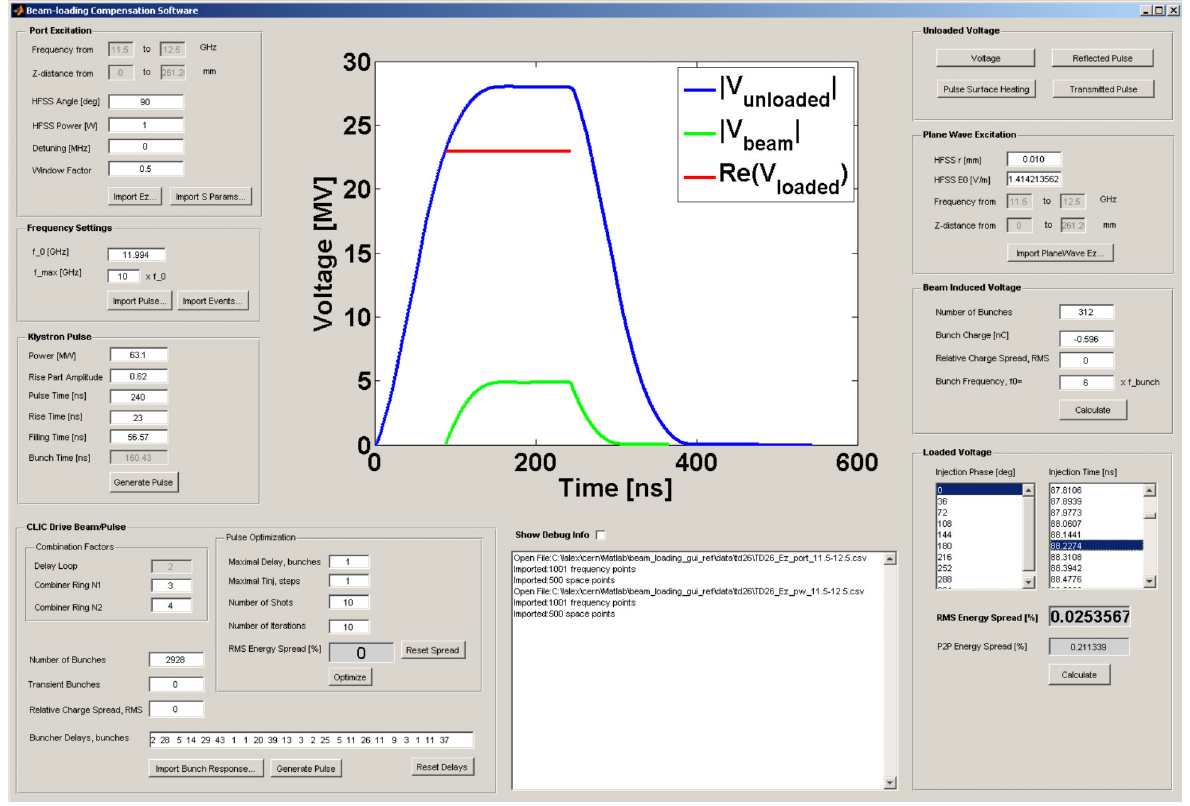
FIG. 14. Screenshot of the main dialog for the developed beam-loading compensation software for CLIC.